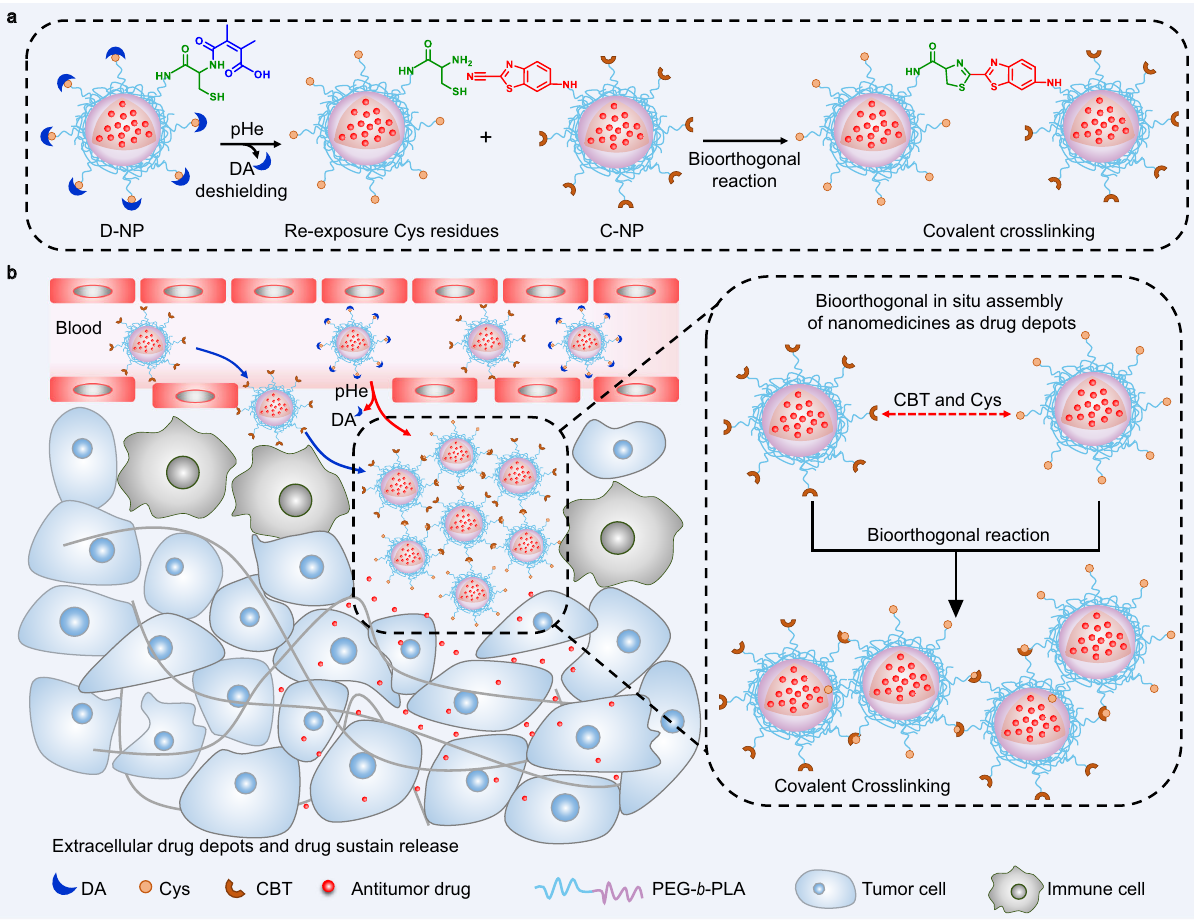
Fig. 1 Schematic illustrating the bioorthogonal in situ assembly strategy to construct drug depots within tumor areas. a Two types of NPs, D-NP and C- NP, undergo a bioorthogonal crosslinking reaction in the acidic tumor microenvironment. The cysteine residues of D-NP are re-exposed under the acidic conditions and can react with the CBT residues of C-NP. b The bioorthogonal in situ-assembled combination of D-NP and C-NP within the tumor area could serve as a drug depot to prolong the retention of the nanomedicine in the tumor site and for sustained release of the anticancer agents for cancer therapy. DA: 2, 3-dimethylmaleic anhydride, pHe: tumor acidity, Cys: cysteine, CBT: 2-cyanobenzothiazole, PEG- b -PLA: polyethylene glycol-polylactic acid block